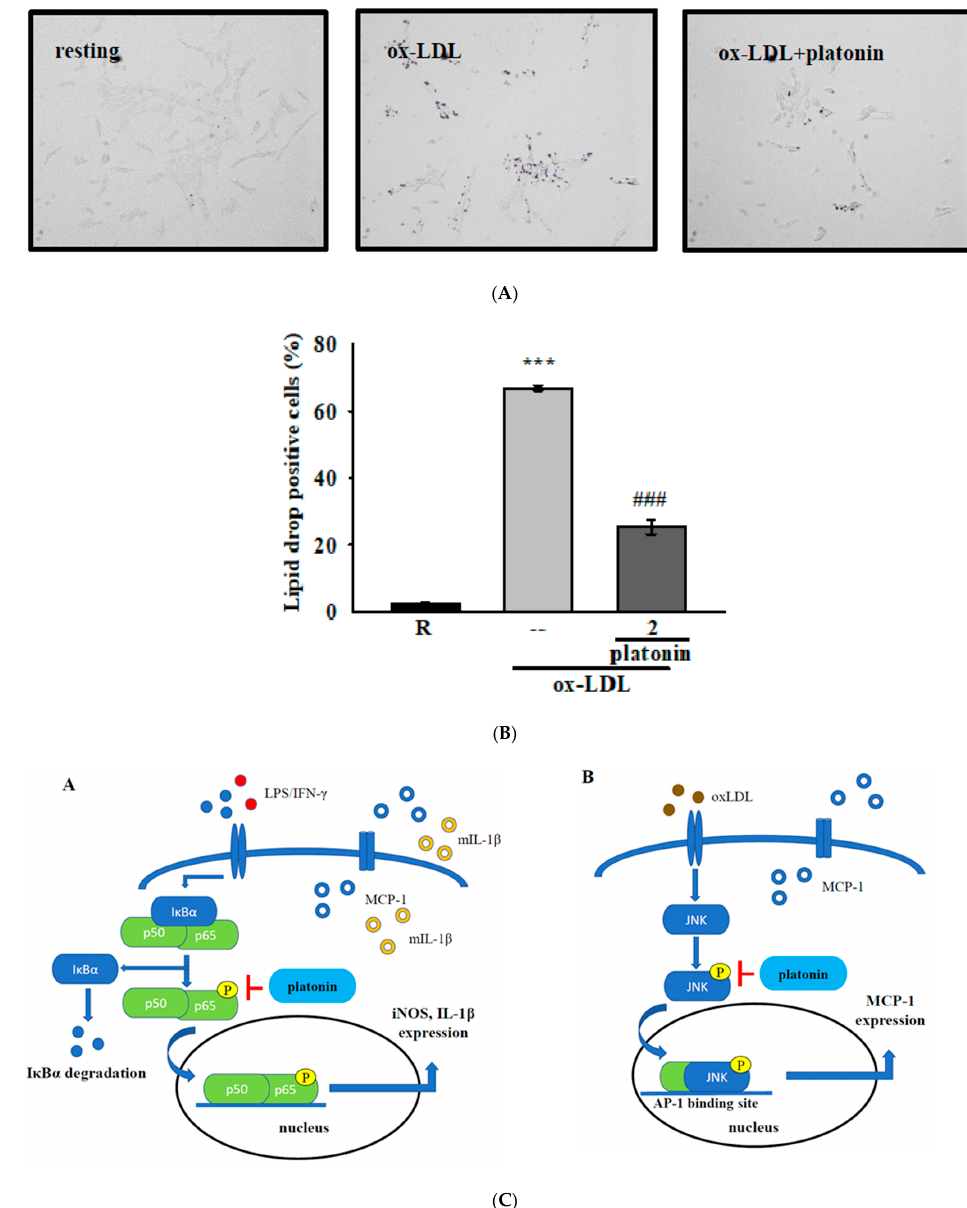
Figure 5. Effect of platonin on lipid drop formation in ox-LDL-stimulated vascular smooth muscle cells (VSMCs). ( A , B ) VSMCs were treated with ox-LDL (50 µ g/mL) for 48 h in the presence or absence of platonin (2 µ M). Oil red O staining was performed as described in “Materials and Methods.” The deep-purple dots indicate cholesterol-laden positive cells. Data are expressed as mean ± S.E.M. ( n = 3); *** p < 0.01 compared with the resting group; ### p < 0.05 compared with the ox-LDL treated group. ( C ) Schematic of the anti-inflammatory mechanisms of platonin in LPS/IFN- γ or ox-LDL-treated